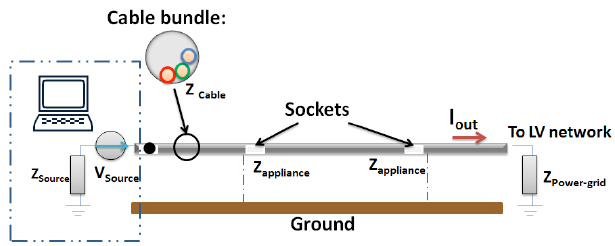
Figure 1: Modelled low voltage test network